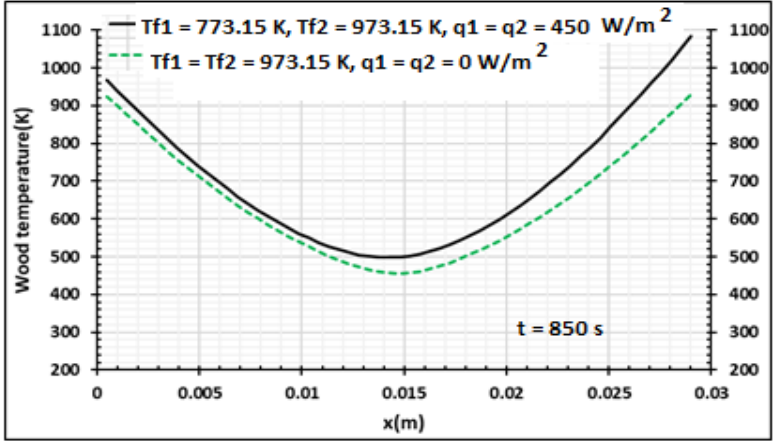
Figure 15. Wood temperature distribution using samples of 30 mm thickness, ρ bo = 700 kg/m 3 . Influence of the contact temperature and heat flux density, t = 850 s.